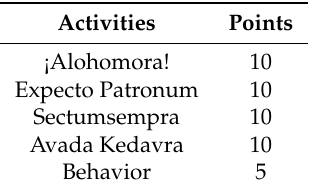
Table 3. Group performance